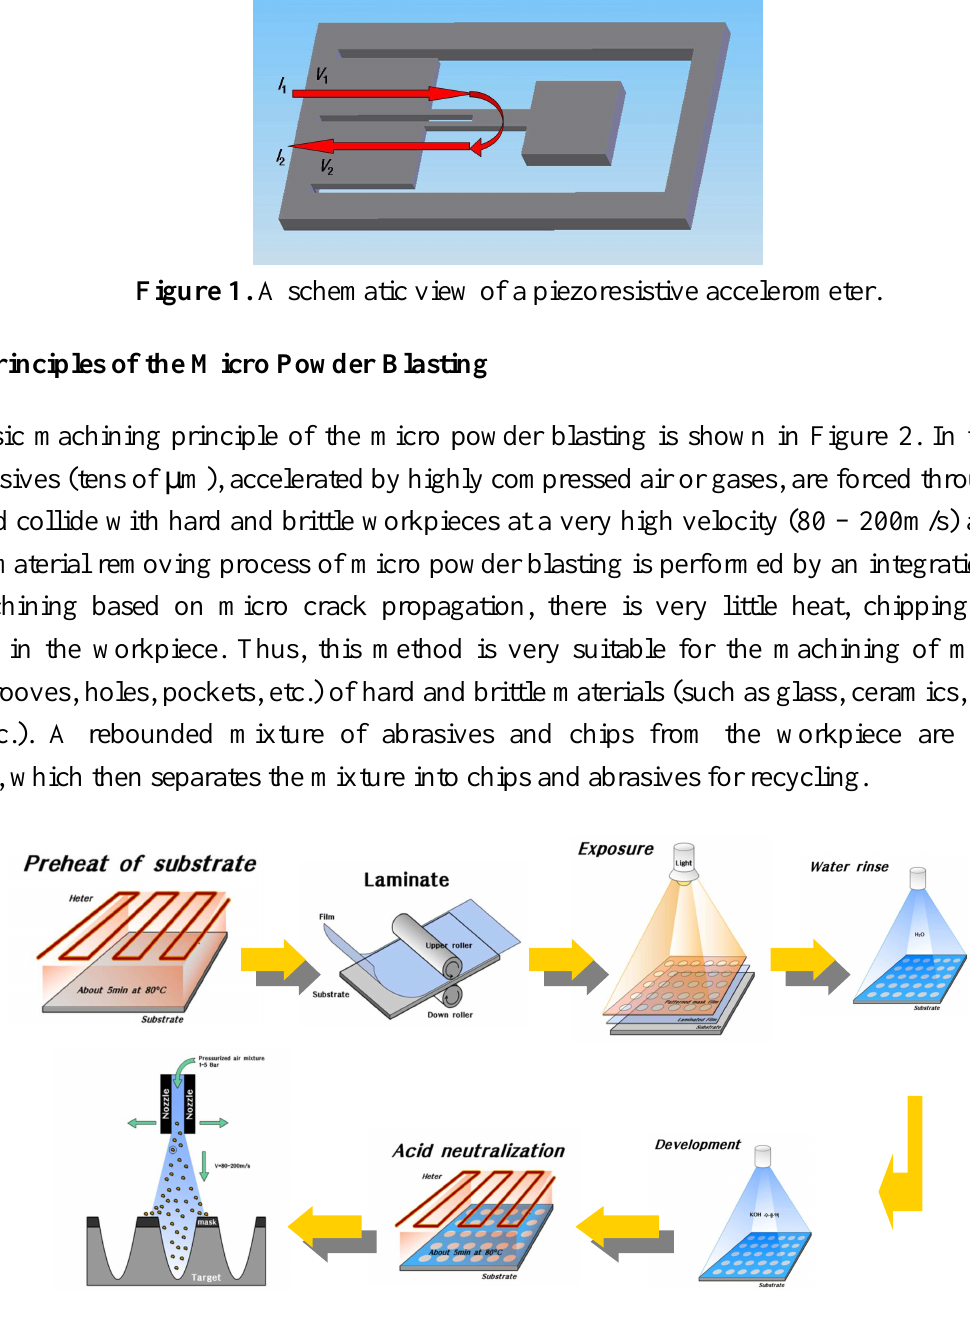
Figure 2. A schematic diagram of the micro powder blasting